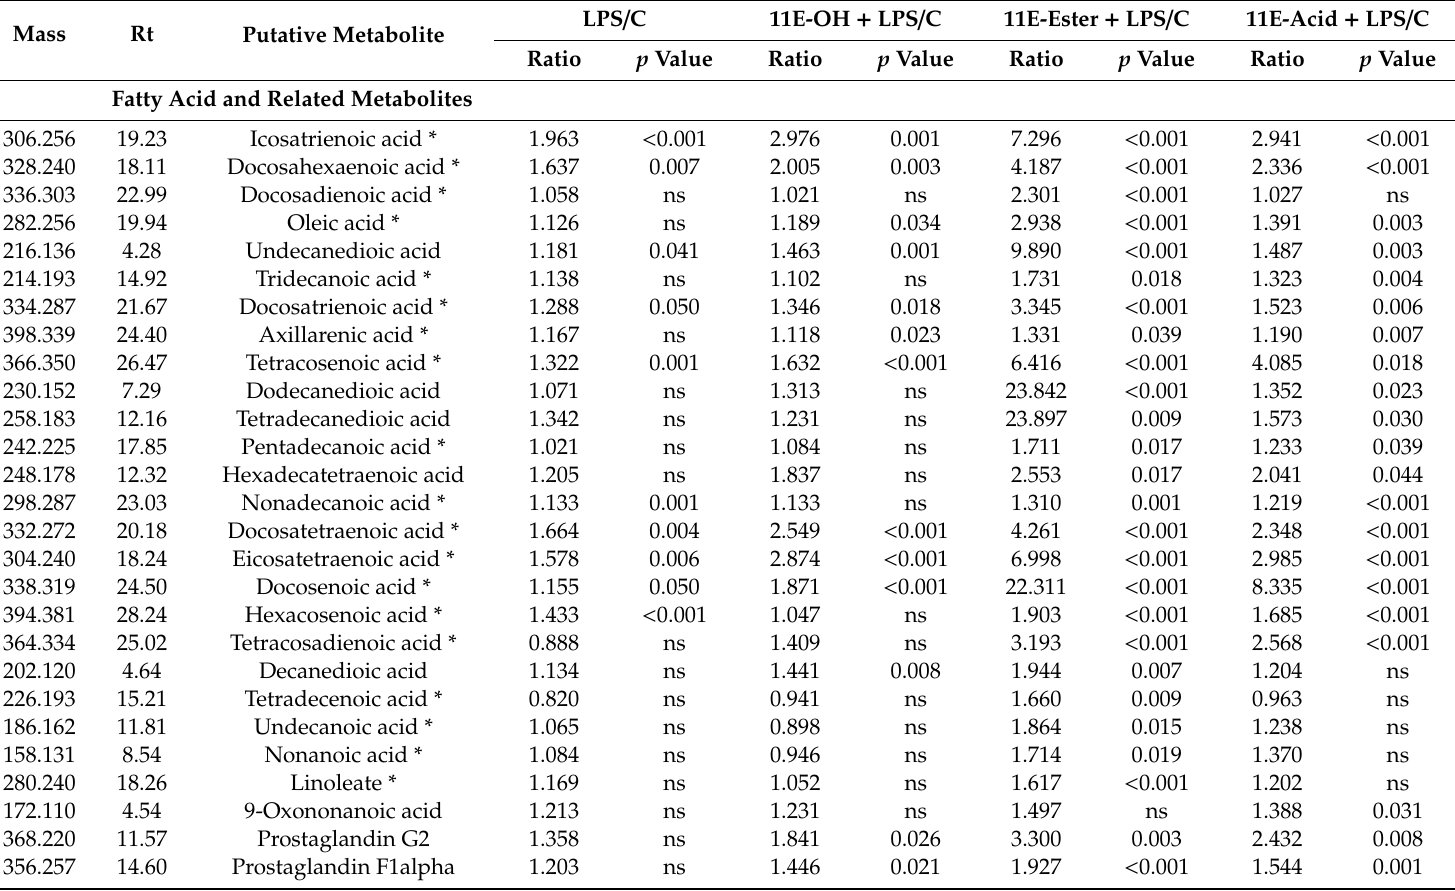
Table 3. Significantly changed non-polar metabolites in THP-1 cells treated with lipopolysaccharide (LPS), alone or in combination with one of three synthetic forms